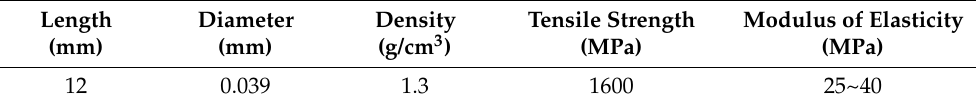
Table 3. Properties of PVA fibers.